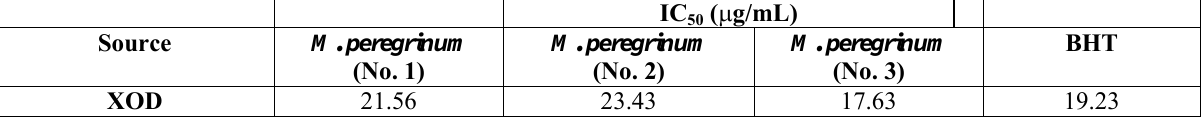
Table 4. IC values ( μ g/mL) of the activities of XOD with Marrubium peregrinum 50 essential oil and and BHT (as a positive control). The essential oils and BHT were diluted in n -hexane (the solvent expressed no antioxidant activity) in the XOD assay.